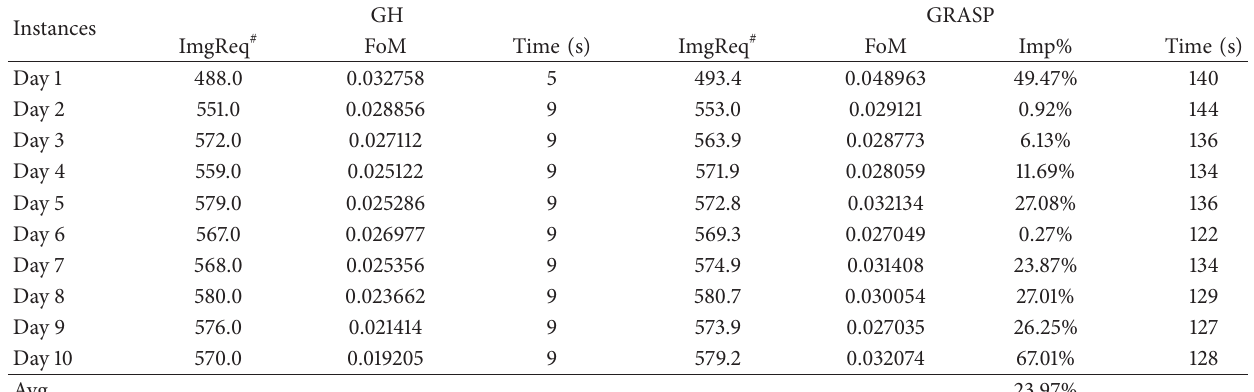
Table 2: Average results of the GH versus